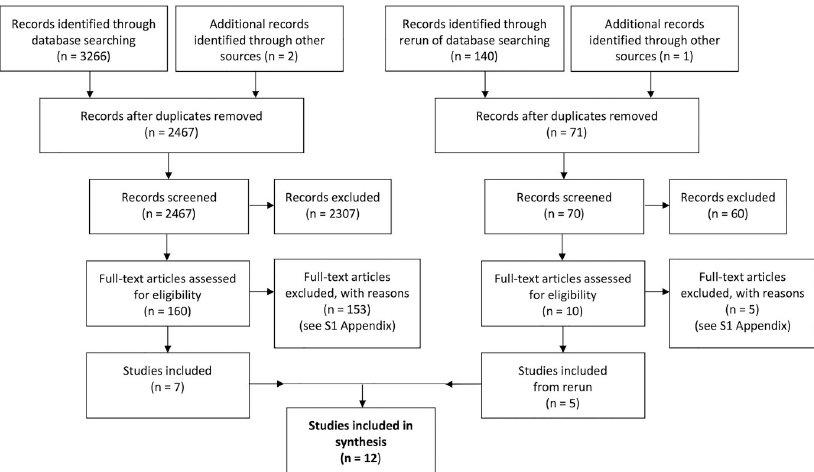
Fig 1. PRISMA flow chart. The flow chart presents the results and screening process of the original searches and the rerun of the searches.